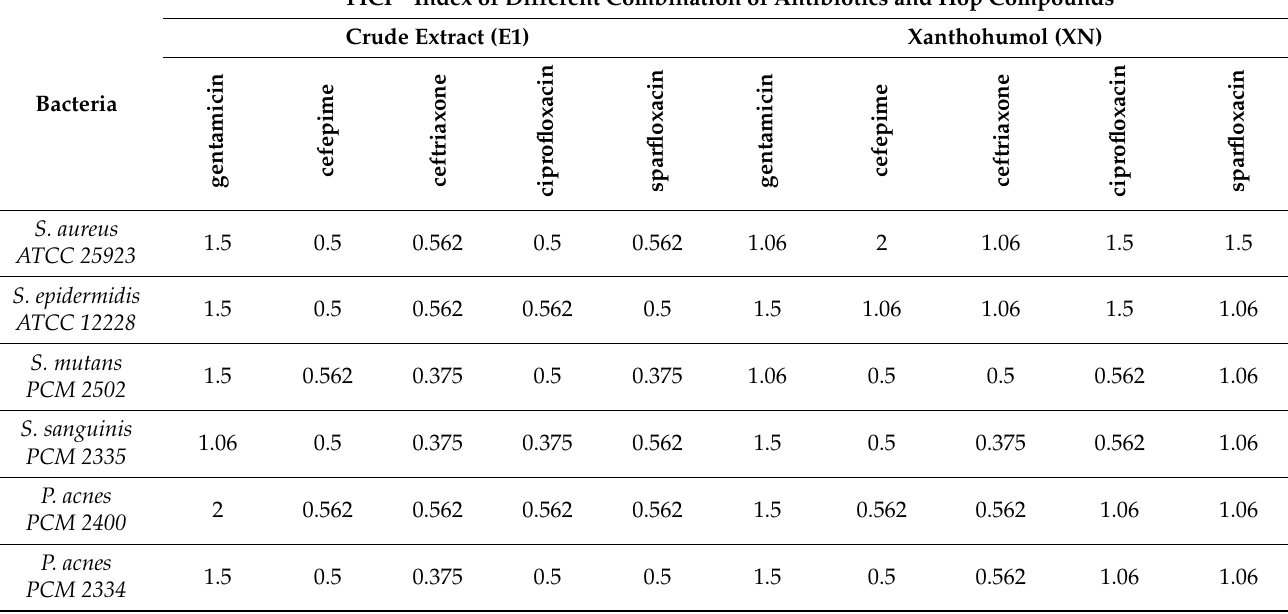
Table 5. Interactions between compounds from Marynka hop variety and selected antibiotics. FICI a Index of Different Combination of Antibiotics and Hop Compounds Crude Extract (E1) Xanthohumol (XN)